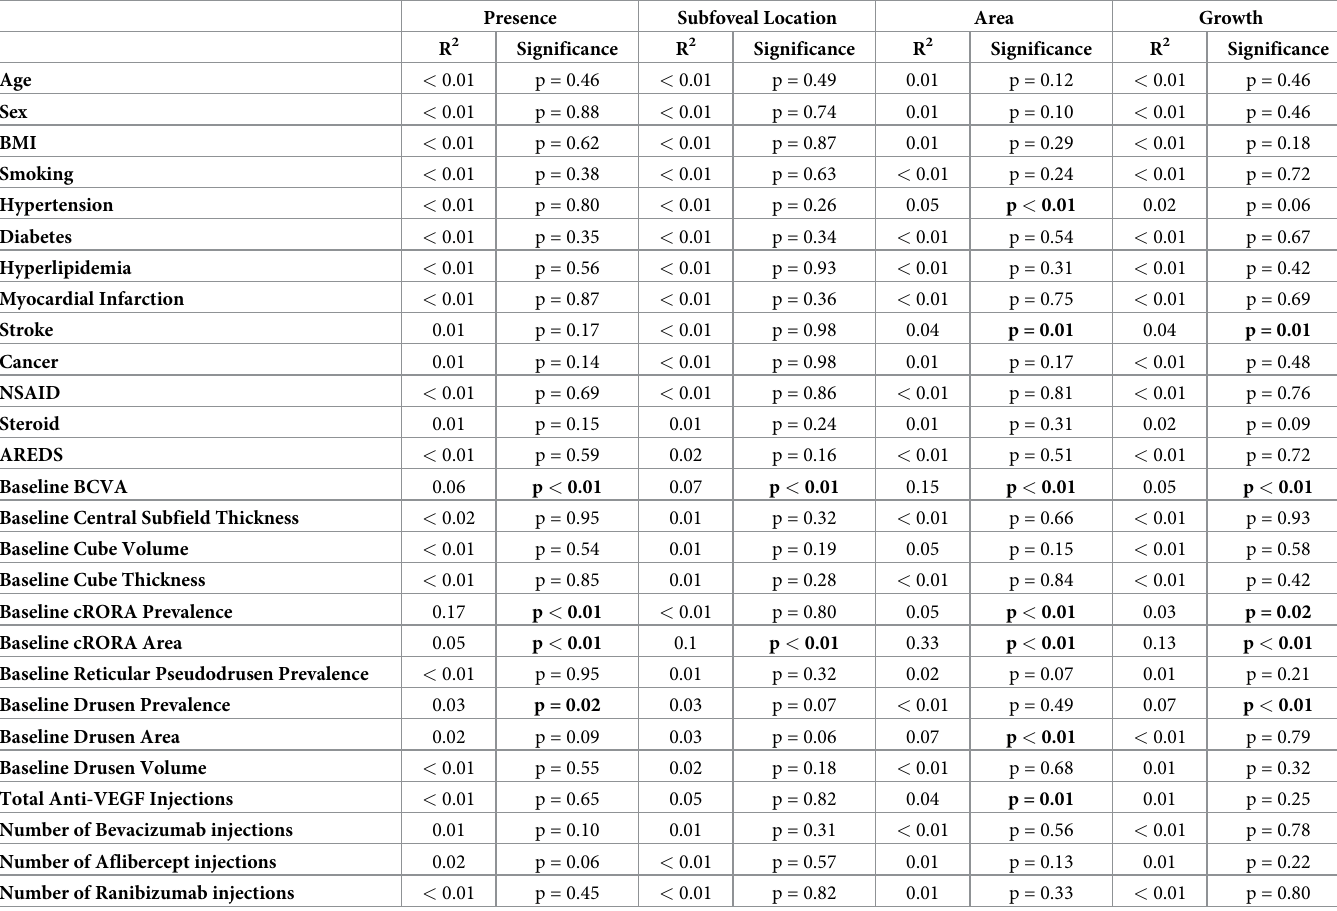
Table 2. Univariate regression analysis between potential risk factors and cRORA outcomes at 24